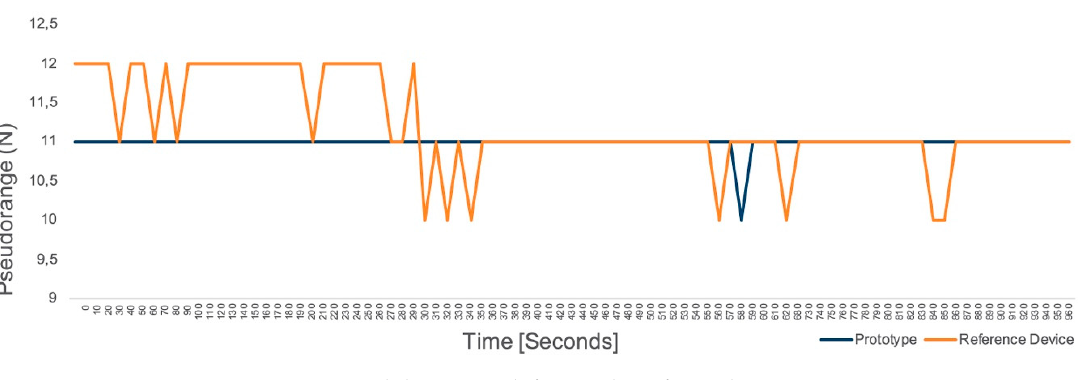
Figure 21. Validation graph for number of pseudoranges.